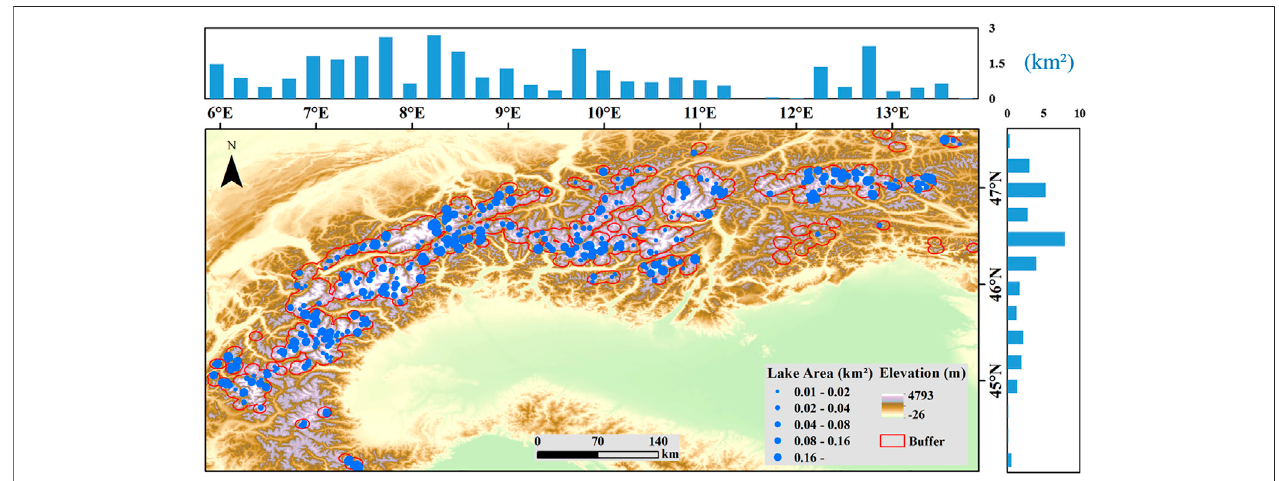
FIGURE1| SpatialdistributionofAlpsglaciallakesin2019.The upper and right panelsshowthestatisticsofandglaciallakeareawithinthe5 kmbufferofglacier terminus at 0.25 ° latitude/longitude summaries.